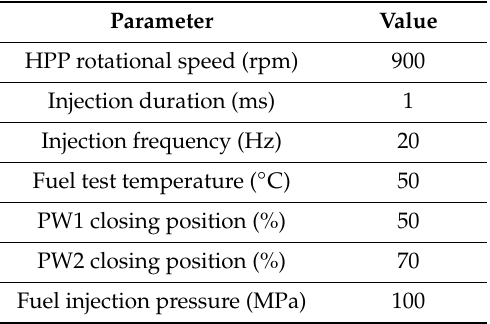
Table 4. Experimental operating conditions of the HPCR fuel injection